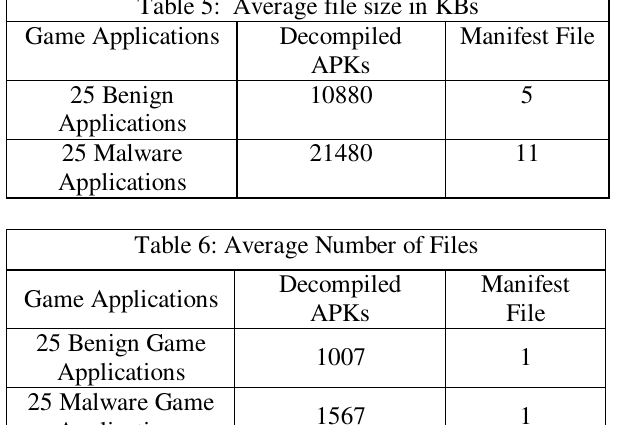
Table 5: Average file size in KBs